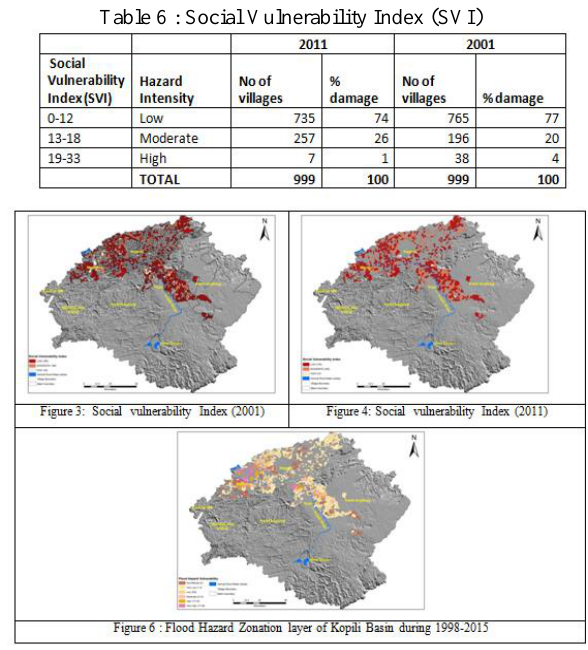
Table 6 : Social Vulnerability Index